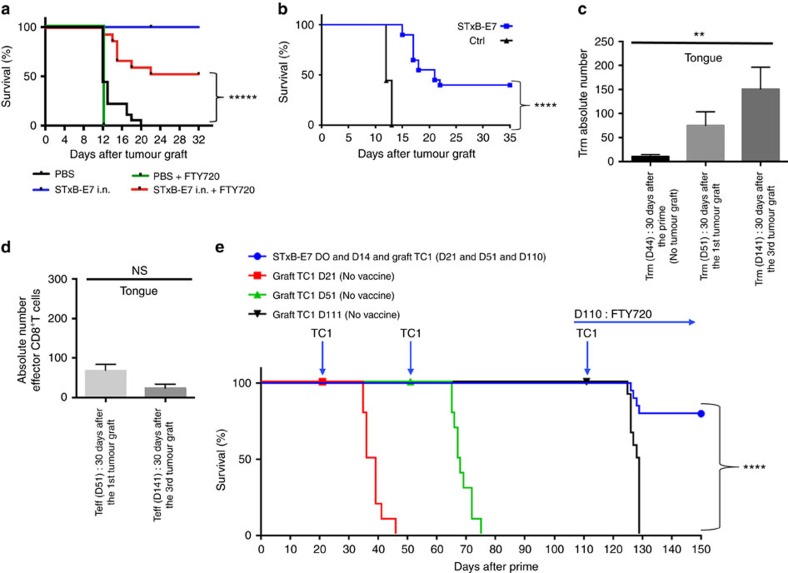
Role of Trm in the control of orthotopic tumours.(a) Mice were i.n. immunized or not with STxB-E7 and αGalCer at D0 followed by a boost at D14 with STxB-E7. TC1 cells were grafted at D21. One day before the tumour challenge, the mice were started to be treated or not daily with FTY720 and monitored for survival. (b) Mice were i.n. immunized or not with STxB-E7 and αGalCer at D0 followed by a boost at D14 with STxB-E7. One month later, mice were grafted with TC1 cells in the tongue. Survival was monitored and represented by a Kaplan–Meier curve. Experiments were repeated at least three times. ****P<0,0001. (c,d) Mice were immunized as in a. Trm (c) and effector CD8+T cells (d) were then measured in the whole tongue 30 days after the boost without TC1 challenge (D44 after priming) for Trm or 30 days after a TC1 submucosae graft at D21 (day 51 after priming) or 30 days after the third TC1 challenge at day 111 (D141 after priming) for both Trm and effector CD8+T cells. One of two representative experiments is shown. (e) Mice were not immunized and grafted with TC1 cells at day 21 or day 51 or day 111 (red filled square). Another (green filled triangle) group of mice were (black filled nabla) immunized with STxB-E7 at D0 and D14 and grafted with TC1 at D21, D51 and D111. FTY720 was injected i.p. from (blue filled circle) D110 (one day before the third tumour challenge) until the end of the experiment. Survival was monitored. Experiments were reproduced three times. Statistical analysis for (a,b,e) used Log-rank test and for (c,d) non-parametric Mann–Whitney test. *****P<0.00001, ****P<0.0001, **P<0.01. Error bars indicates s.e.m. NS, not significant.